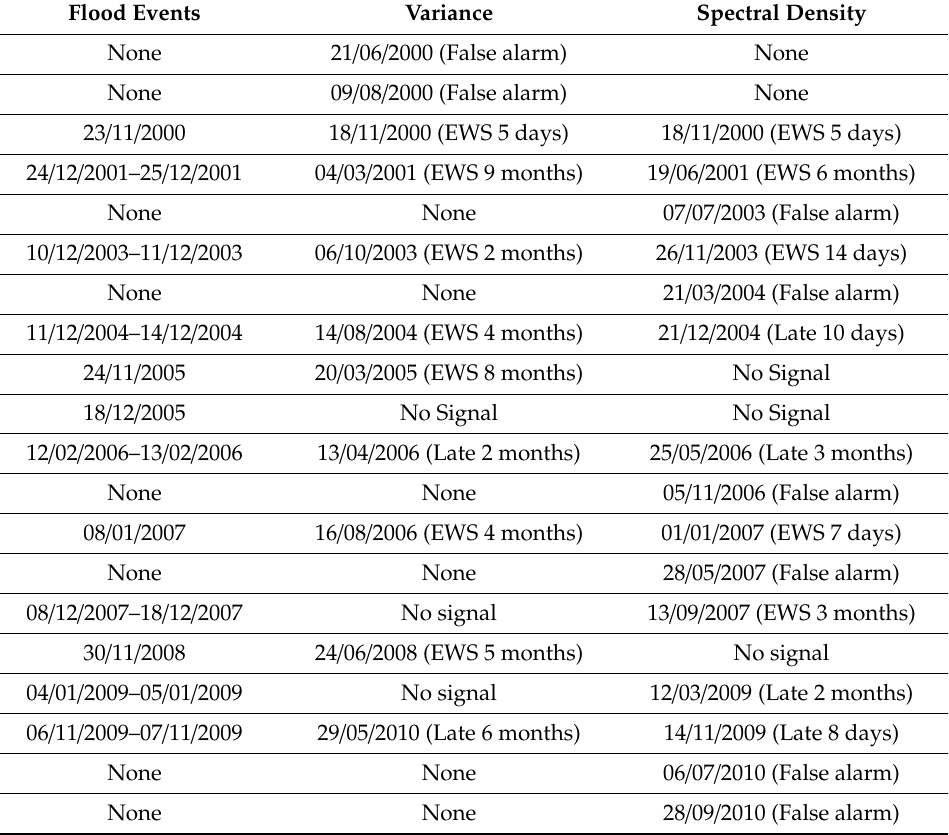
Table 3. Results of the early warning system (EWS) from the water level data determined by Kendall’s tau exceeding a threshold value of 0.9 for each CSD indicators’ variance and average spectral density at low